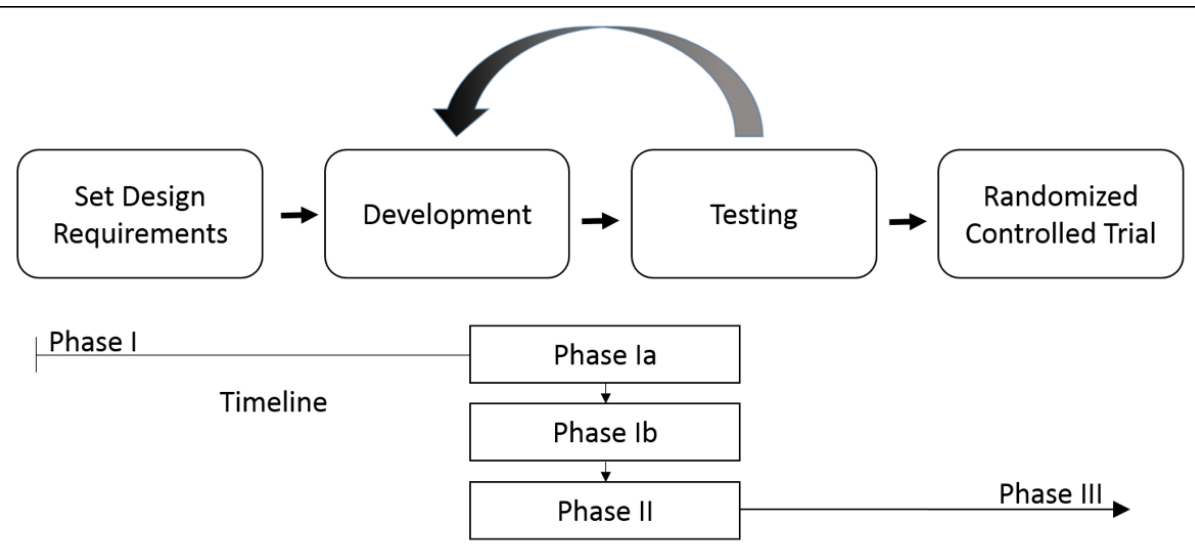
Figure 1. The design, test, and redesign approach in three distinct phases. In phase I, the app was developed and tested twice. A prepilot check (Ia) was performed to test usability. Subsequently, the app was tested in a mixed-methods pilot study (Ib). In phase II, further development was performed and the new app was re-evaluated with another mixed-methods pilot study (manuscript of pilot studies in preparation)